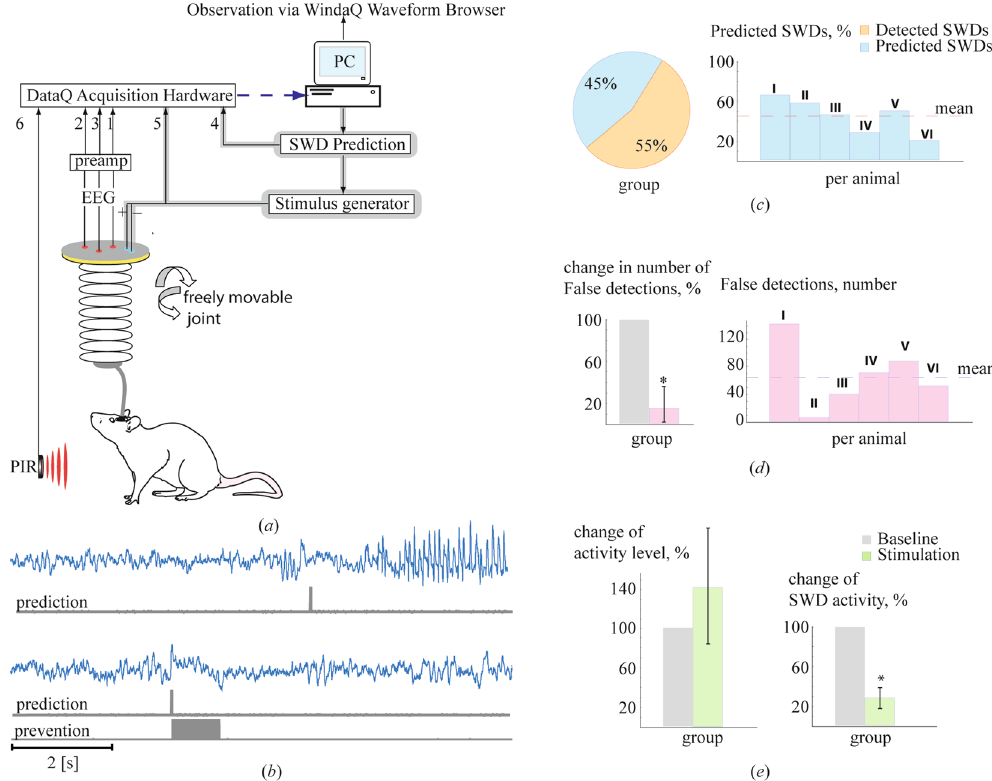
Figure 2. ( a ) The experimental setup of the brain-computer interface. The set of analog inputs 1–6 of the acquisition hardware correspond to the three EEG channels (1-3), a marker for predictions (4), the stimulation pulse train of 1 sec (5) and the signal from the passive infrared registration system (PIR) for movement detection (6), respectively. The dashed line corresponds to the digital input of the PC, the feedback is shown by the shadow. ( b ) The prediction (upper case) and prevention (lower case) of the SWD/absence seizure by delivering a pulse train of 1.0 second duration. ( c ) Mean percentage of correctly predicted and correctly detected SWDs by the algorithm including two additional critera (see para on “On-line precursor detection”). The data are from an one hour baseline recording of 6 WAG/Rij rats of experiment 2; ( d ) Number of false positives for each individual rat generated by the revised algorithm within the 1 hour baseline of the 6 WAG/Rij rats (right panel), and the relative decrease in the false positives rate (left pannel) between the first algorithm (gray) and the second algorithm (red). Note, to determine the relative decrease, one hour EEG recordings of rats of the first six WAG/Rij rats were analyzed by the algorithm without the two additional criteria and the false positive counts of this analysis were taken as 100% reference. ( e ) The total duration of the epileptic activity and the behavioral activity during the baseline and the stimulation session, averaged over the group of rats. The error bars show the standart error of the mean of the